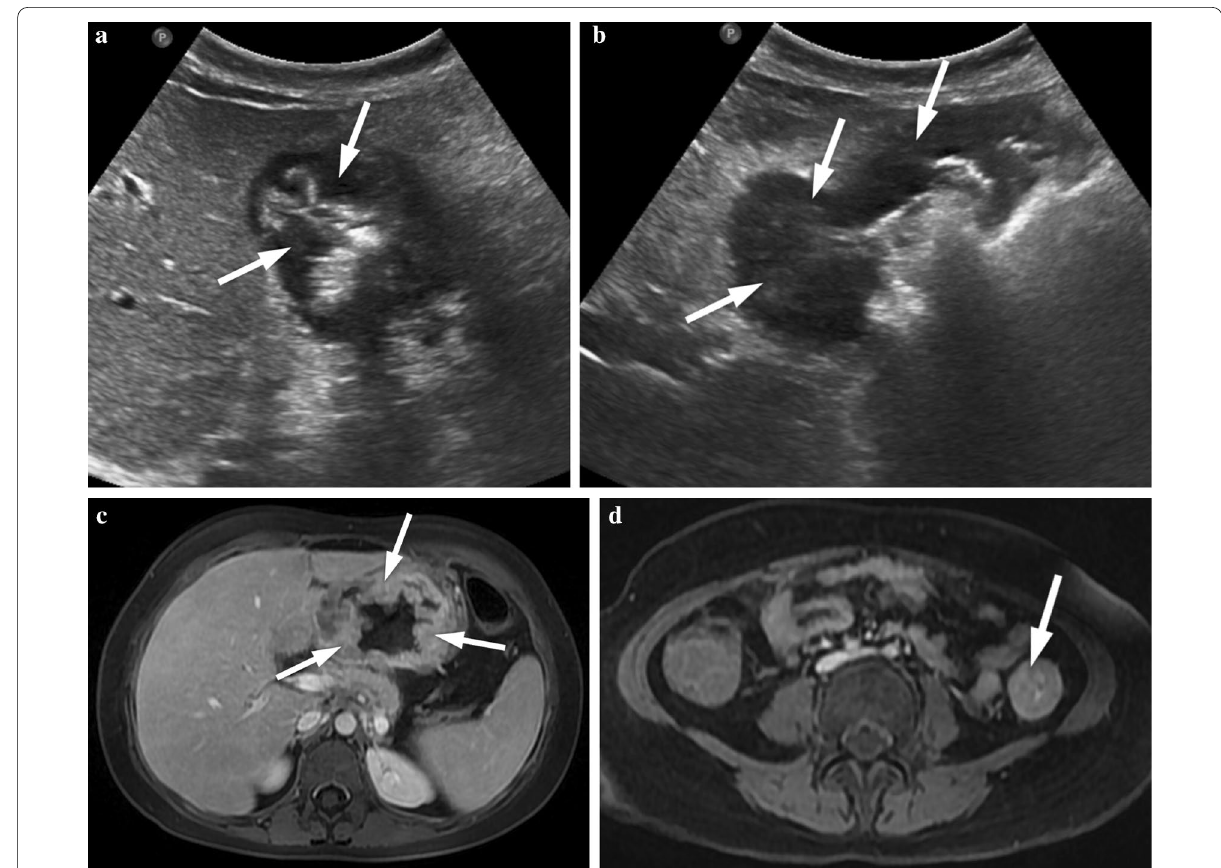
Fig. 12 a–d A 16-year-old girl with gastric adenocarcinoma (signet ring cell carcinoma) and colon adenocarcinoma. a, b US images show increased hypoechoic gastric wall thickening (arrows). c, d Post-contrast T1-weighted images show diffuse increased wall thickening in the stomach and increased wall thickening in the descending colon (arrows). Postoperative histopathological diagnosis was gastric adenocarcinoma with DNA mismatch repair deficiency. The patient was diagnosed with Lynch syndrome (hereditary nonpolyposis colorectal